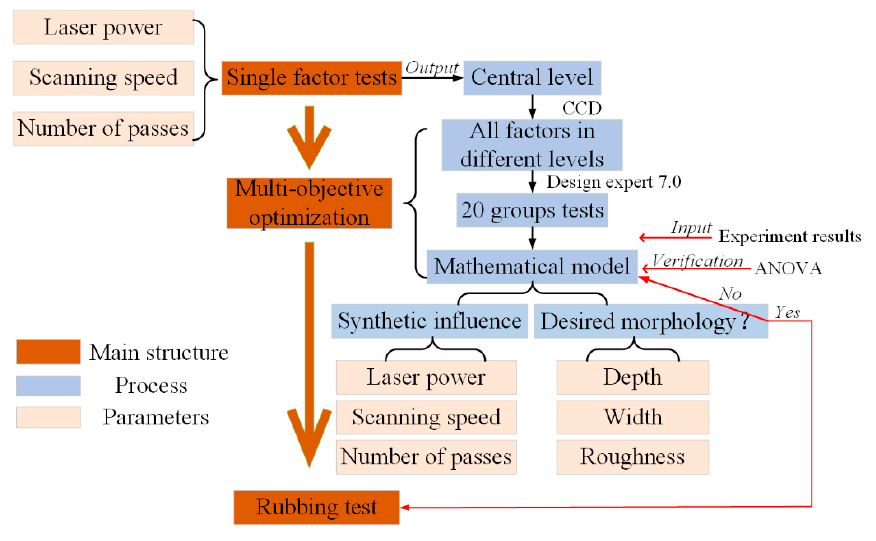
Figure 2. Experimental design.